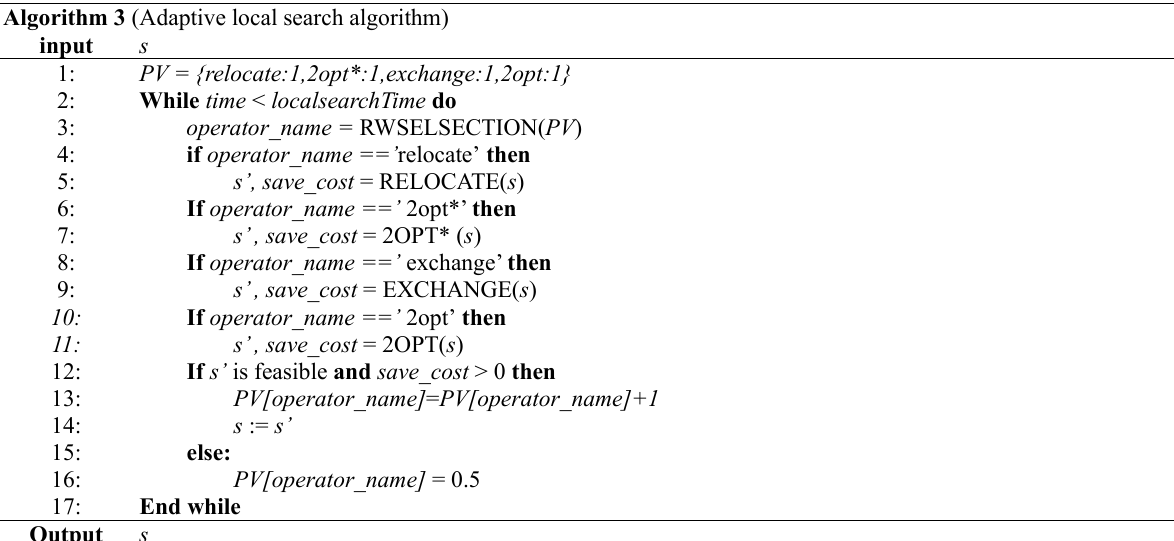
Algorithm 3 (Adaptive local search algorithm)